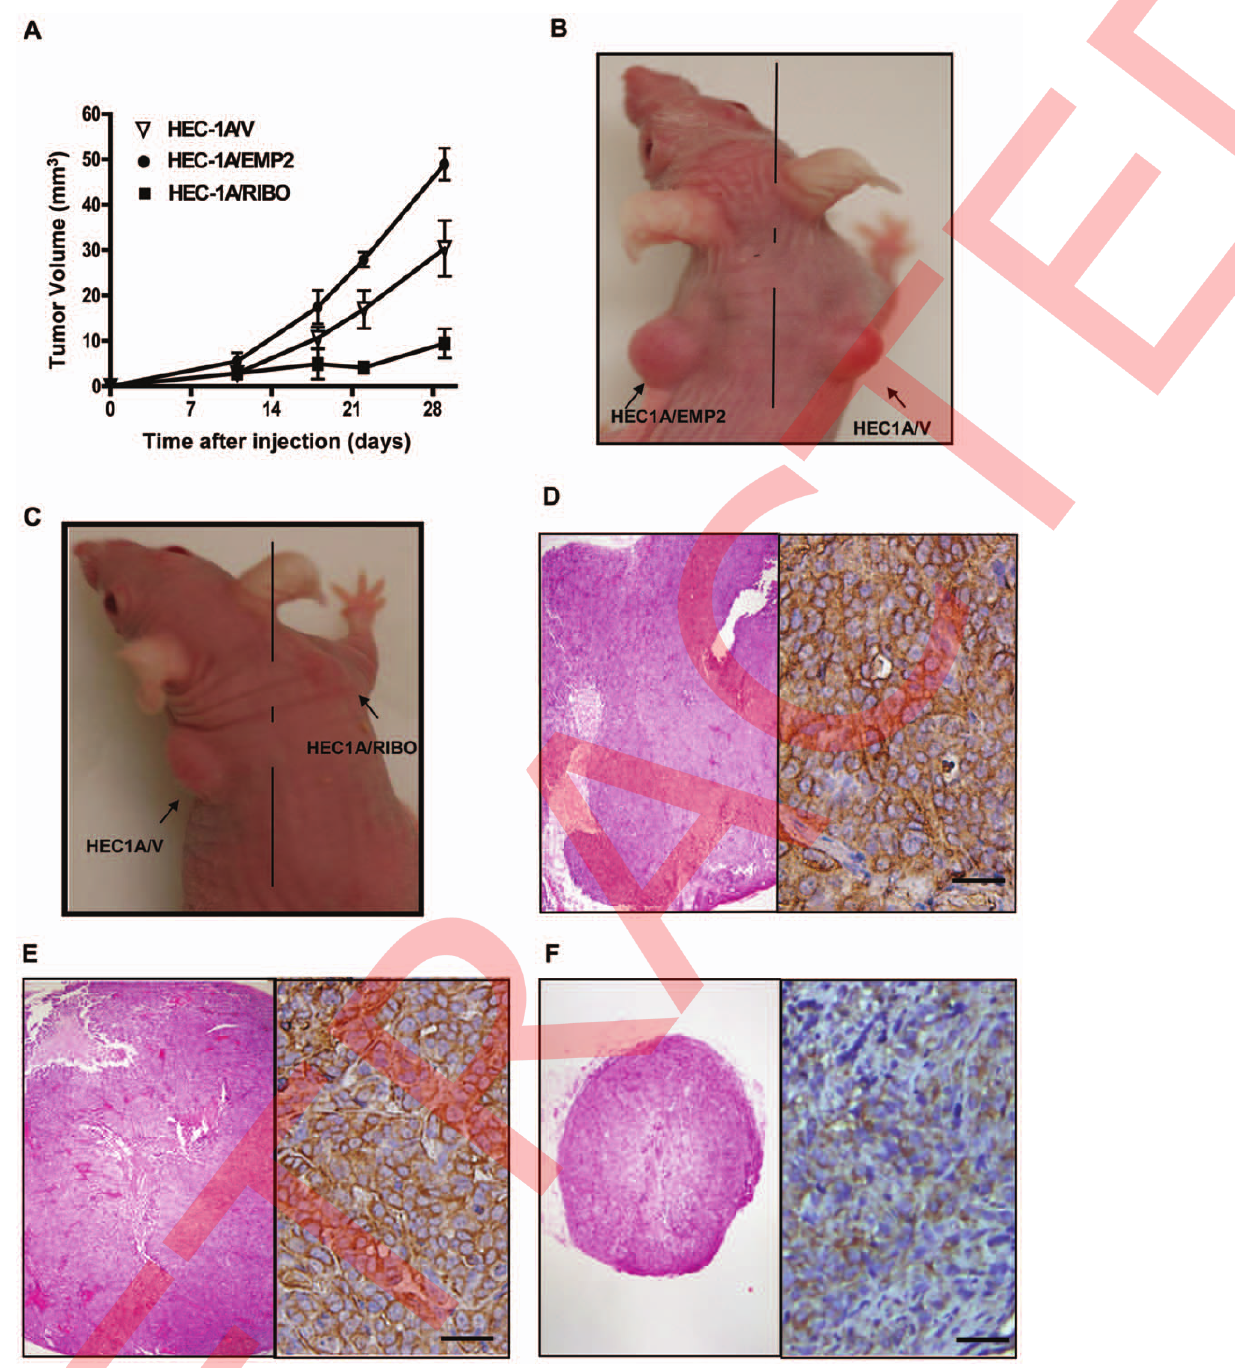
Figure 1. Tumor volume is increased in HEC-1A/EMP2 tumors. (A) HEC-1A/EMP2, HEC-1A/V, and HEC-1A/RIBO cells were injected s.c. into nude mice. Tumor volume was determined using calipers. HEC-1A/EMP2 tumors were larger than tumors injected with HEC-1a/V and HEC-1a/RIBO cells. Values are averages ( 6 SEM, n=6). Comparison by ANOVA, p , 0.05 (B) Representative nude Balb/c mouse displaying HEC-1A/EMP2 and HEC-1A/ V subcutaneous tumors. (C) Representative Balb/c nude mouse displaying HEC-1A/V and HEC-1A/RIBO subcutaneous tumors. At day 30, HEC-1A/ EMP2 (D), HEC-1A/V (E), and HEC-1A/RIBO (F) tumors were excised, fixed, and stained by hematoxylin and eosin or EMP2. H/E Magnification, 40X; EMP2 Staining Magnification, 400X. Scale bar = 10 m M. doi:10.1371/journal.pone.0019945.g001 Both inhibition of Akt phosphorylation and EGFR using erlotinib To determine the contribution of select signaling pathways on had no significant effect on both HEC-1A and Ishikawa cell endometrial cancer cell migration, inhibitors were added to migration. In contrast, both the FAK-Src small molecule HEC-1A (Figure 2E) or Ishikawa cells (Figure 2F). Cells were inhibitor PP2 and the Src family inhibitor dasatinib significantly then assayed for their response to migrate and close the wound.